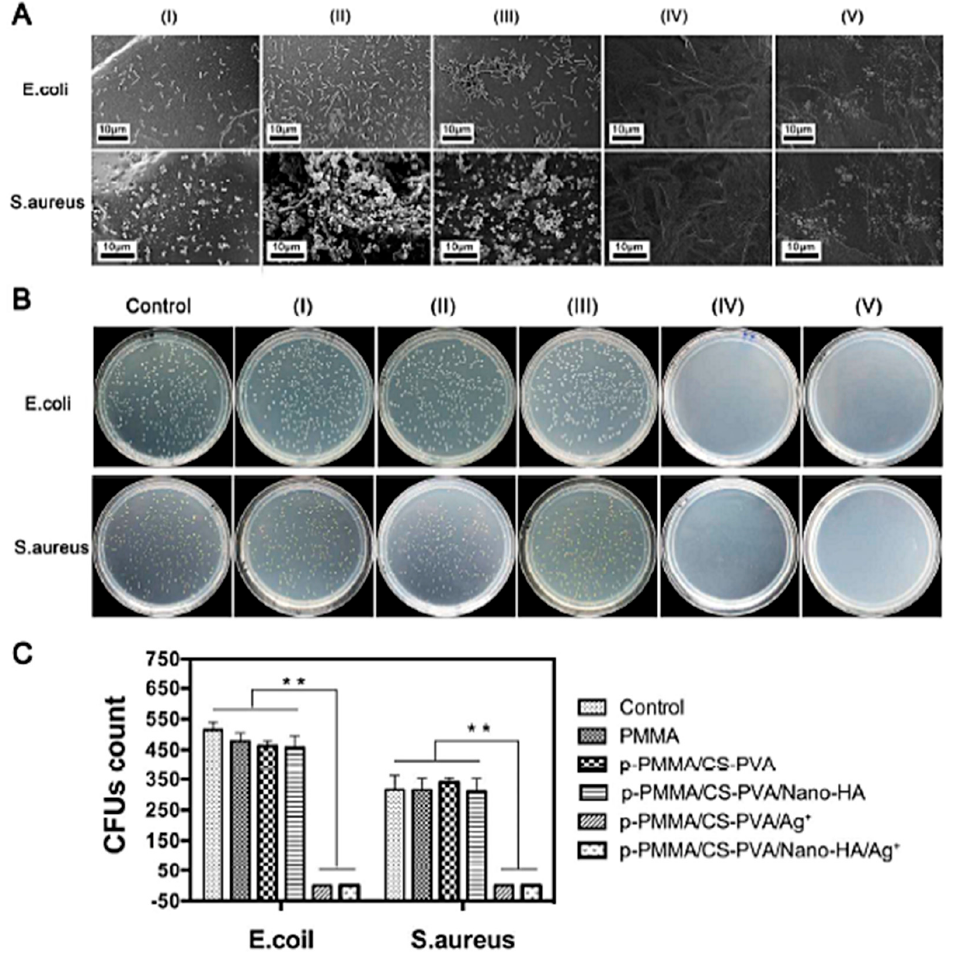
Figure 6. Contact bacteriostatic ( A ) and sustained-release bacteriostatic ( B , C ) of polymethyl methacrylate (PMMA)-based cements in E. coli and S. aureus : (I) PMMA cement; (II) PMMA cement functionalizedwithahydrogelofchitosanandpoly(vinylalcohol)(PVA)(p-PMMA / CS-PVA);(III)PMMA cement functionalized with a hydrogel of chitosan and PVA containing nano-sized hydroxyapatite (p-PMMA / CS-PVA / Nano-HA); (IV) PMMA cement functionalized with a hydrogel of chitosan and PVA containing silver ions (p-PMMA / CS- PVA / Ag + ); (V) PMMA cement functionalized with a hydrogel of chitosan and PVA containing nano-sized hydroxyapatite and silver ions (p-PMMA / CS-PVA / Nano-HA / Ag + ). Statistical significance: * p < 0.05; ** p < 0.01. Reproduced from Wang et al., 2016 [111], with permission from The Royal Society of